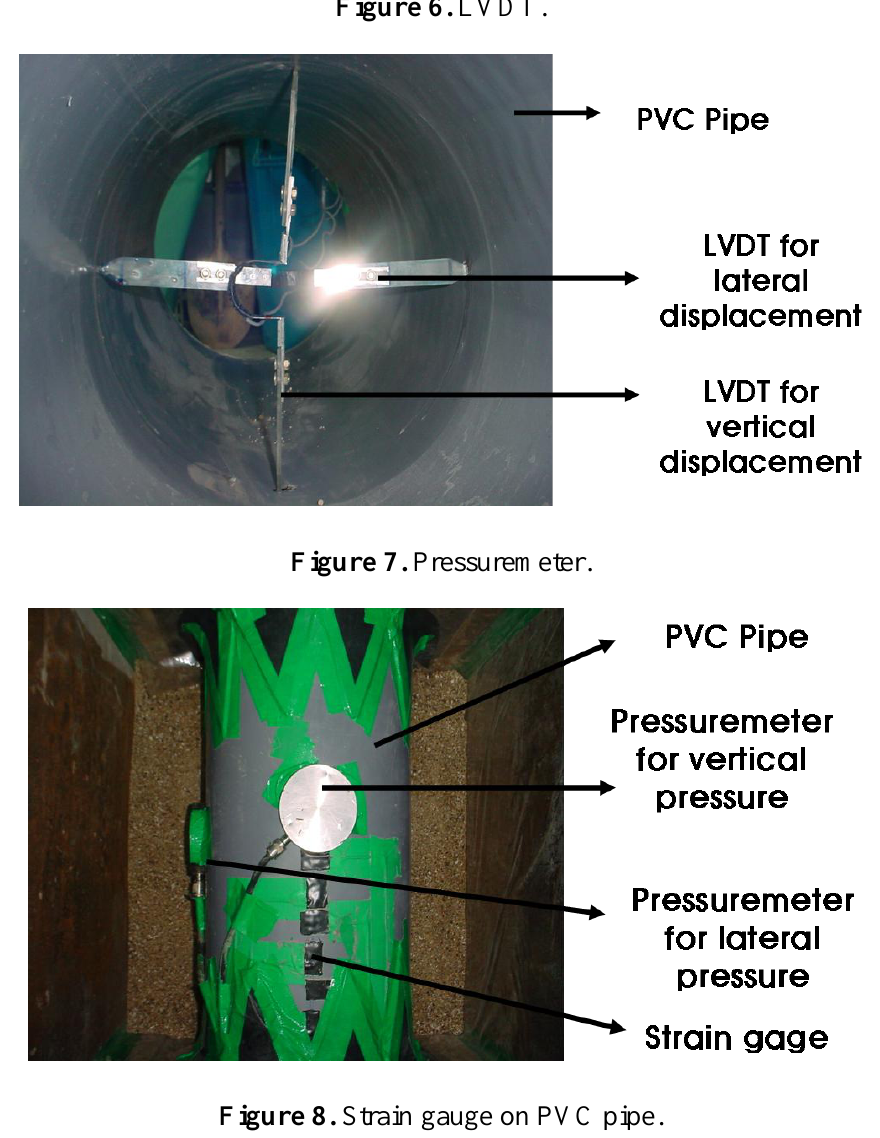
Figure 8. Strain gauge on PVC